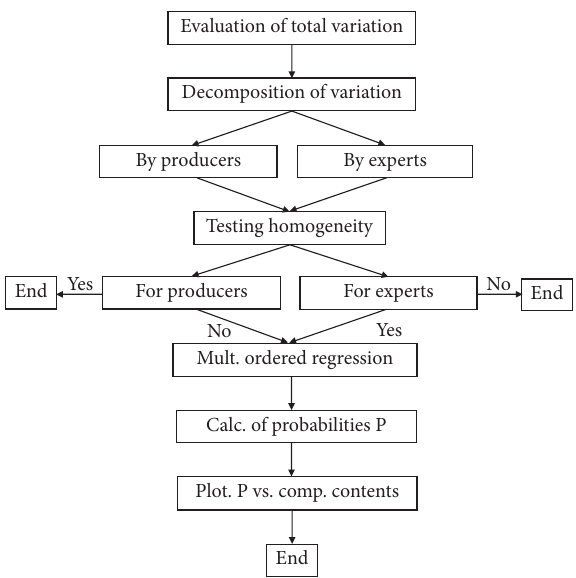
Figure 1: Flowchart of the data treatment. Table 1: Frequencies of the responses on the quality properties of the sausage.